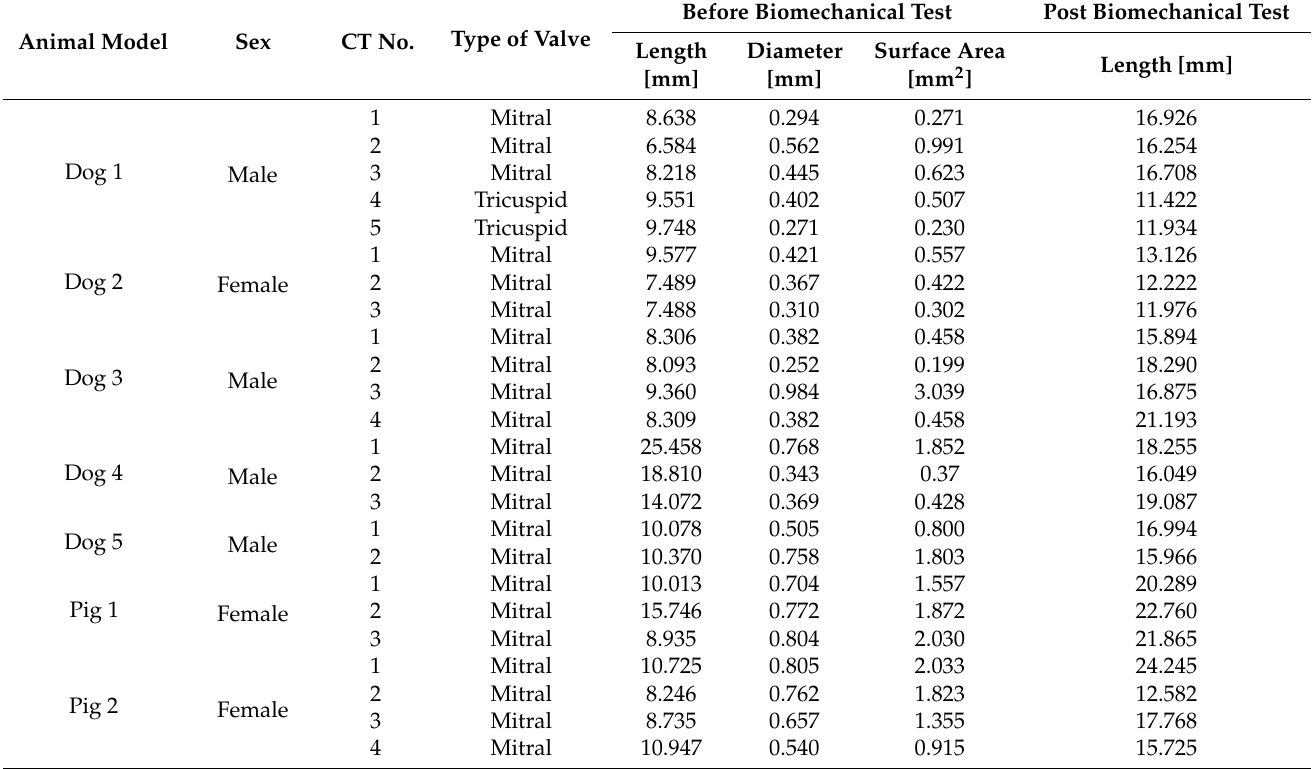
Table 1. Characteristics of each CT taken for biomechanical